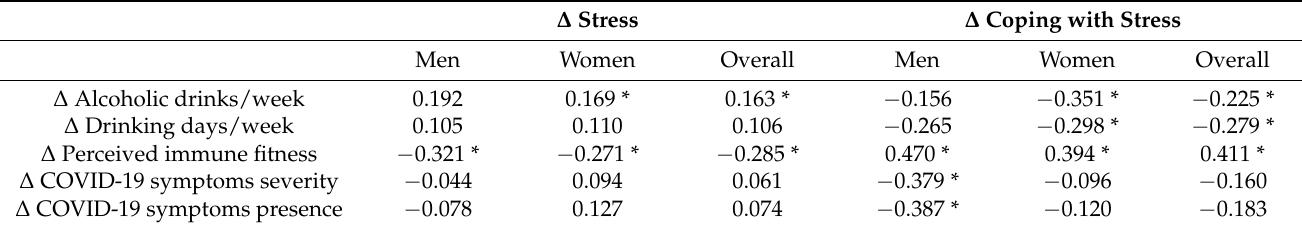
Table 6. Relationship of stress and coping with stress with other study outcomes. ∆ Stress ∆ Coping with